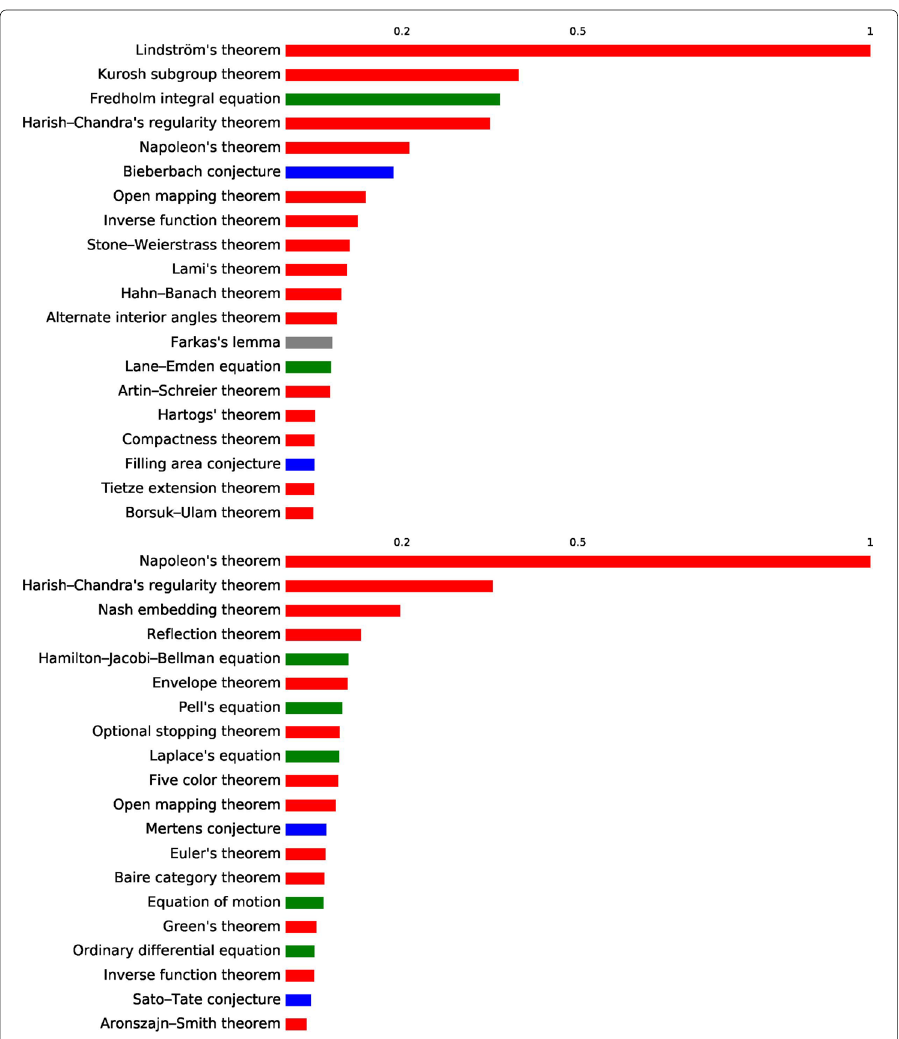
Fig. 9 Concept importance in cycles 20 most important concepts appearing in H 1 cycles (top) and H 2 cycles (bottom). The bars length corresponds to the number of appearances in cycles divided by the number of appearance in edges and triangles